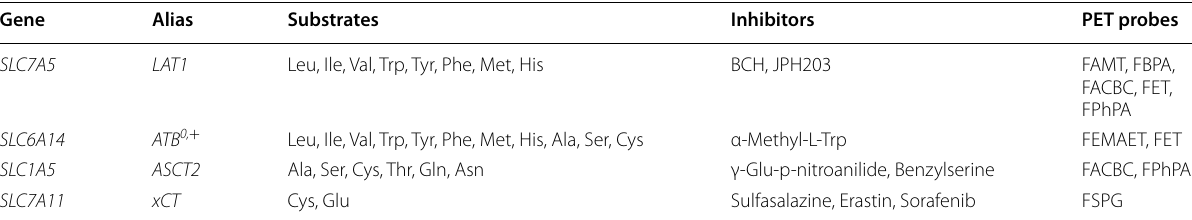
Table 1 Properties of tumor-related amino acid transporters